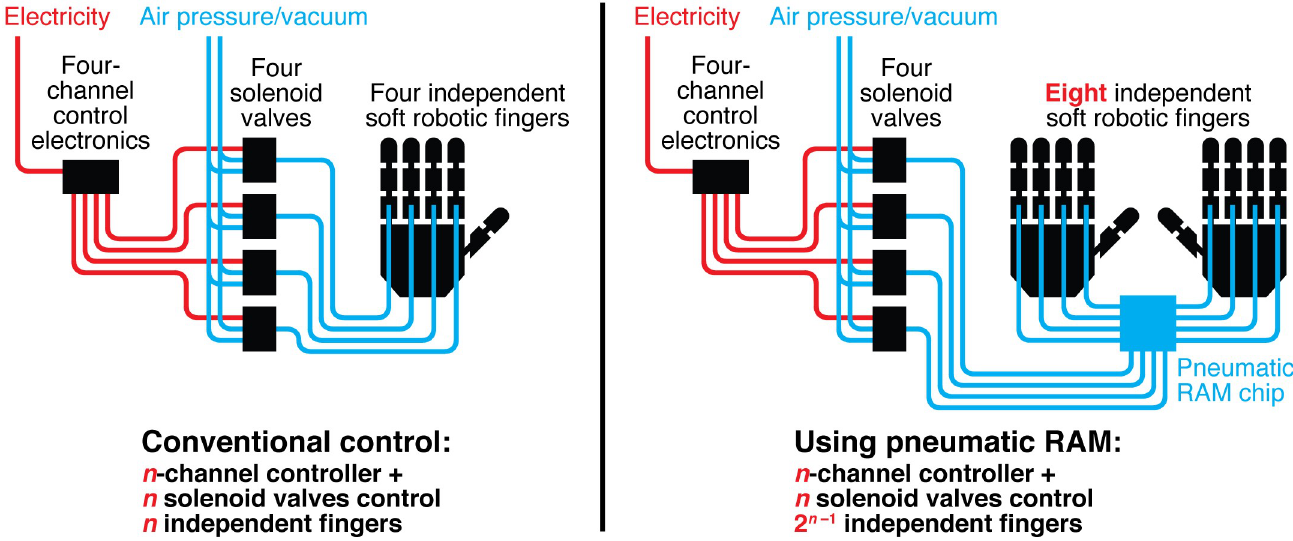
Fig 1. Conventional methods for controlling pneumatic soft robots require a dedicated electronic control line and solenoid valve for each independent actuator (left). Using our pneumatic random access memory (RAM), the same amount of electromechanical control hardware can operate many more actuators while still providing independent control of each actuator